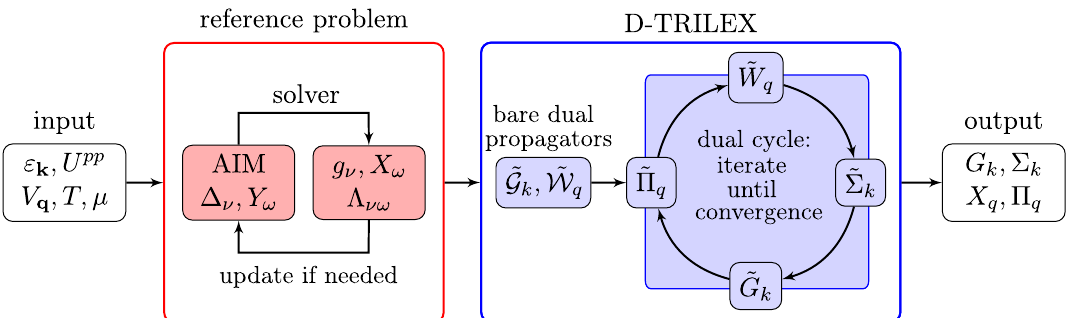
Figure 2: Workflow of the D-TRILEX method. The input consists in the parameters of the electronic lattice problem (Init.1-2 in the main text). The red box indicates the solution of the reference impurity problem (Init.3), that in some case has to be updated until self-consistency is reached (for instance in DMFT, EDMFT and cluster DMFT). The blue box contains the operations performed in the dual space, i.e. the calculation of the bare dual propagators (Init.4) and the self-consistency cycle on the dual quantities (St.2). The output consists in the Green’s function, self-energy, susceptibility and polarization operator of the lattice problem, obtained by applying the exact relations between lattice and dual quantities